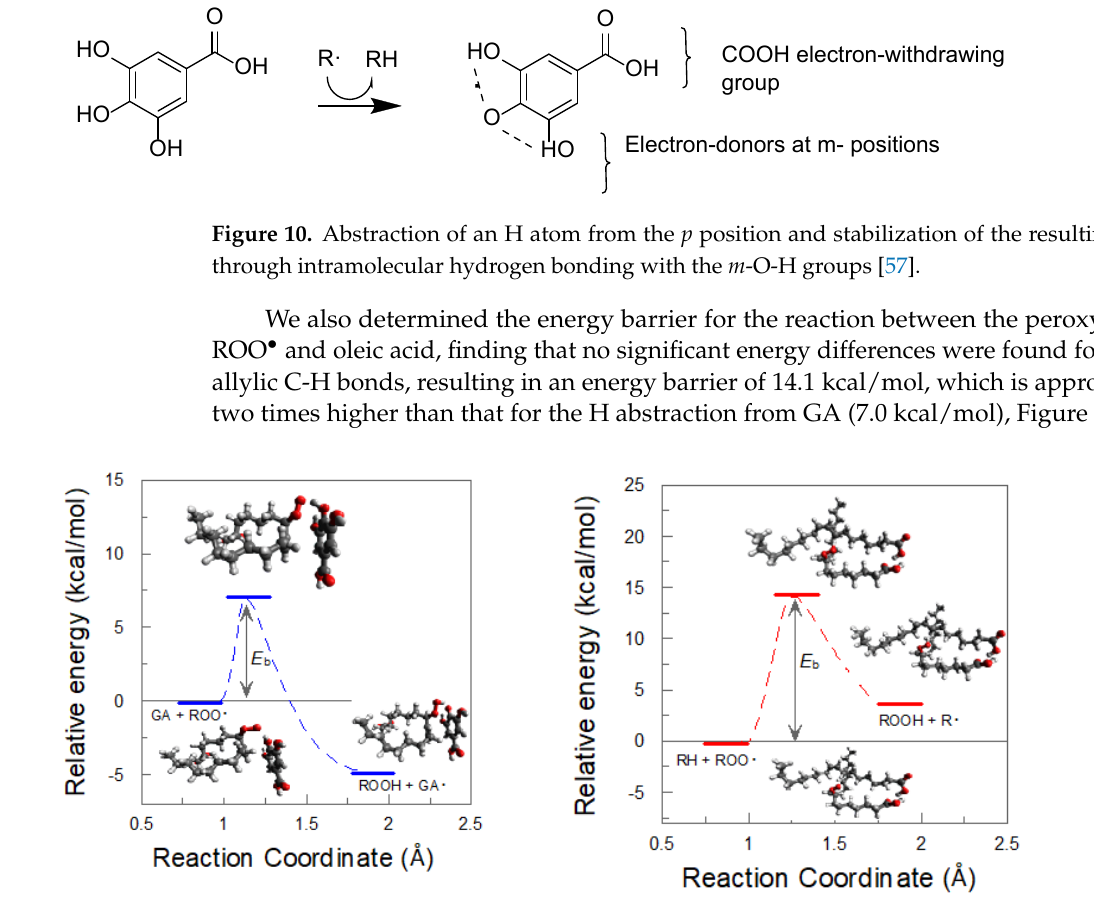
Figure 11. Energy barriers (Eb) profiles and transition states (TS) for the reaction of the peroxyl radical derived from oleic acid, ROO • , gallic acid (GA, left ) and oleic acid (RH, right ). Four QM/MM simulations were performed starting from the configurations of the initial, intermediate and final parts of the whole simulation to minimize computation